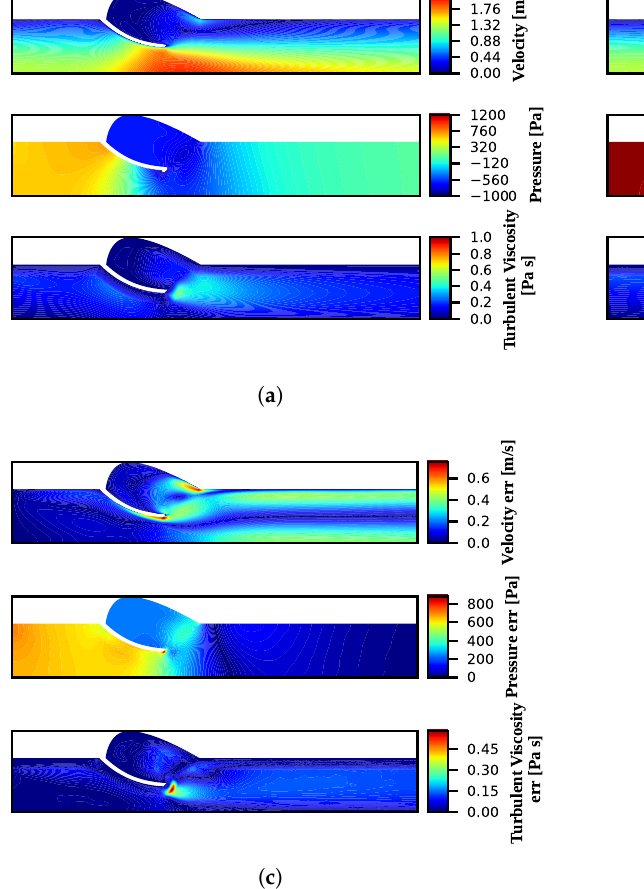
Figure 12. Turbulent flow results for a valve angle of 45 ◦ : ( a ) FVM pressure, velocity and turbulent viscosity fields; ( b ) PINN pressure, velocity and turbulent viscosity fields; ( c ) absolute difference between the fields predicted by the PINN and FVM. Table 6. Simulation Cases: